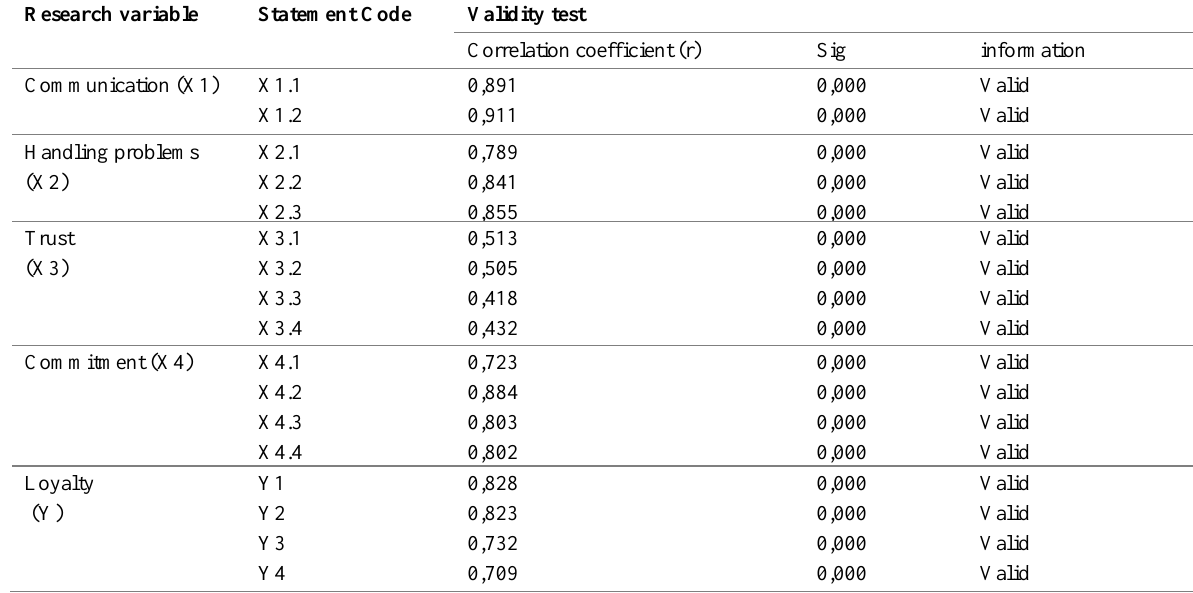
Table 1: Validity test results